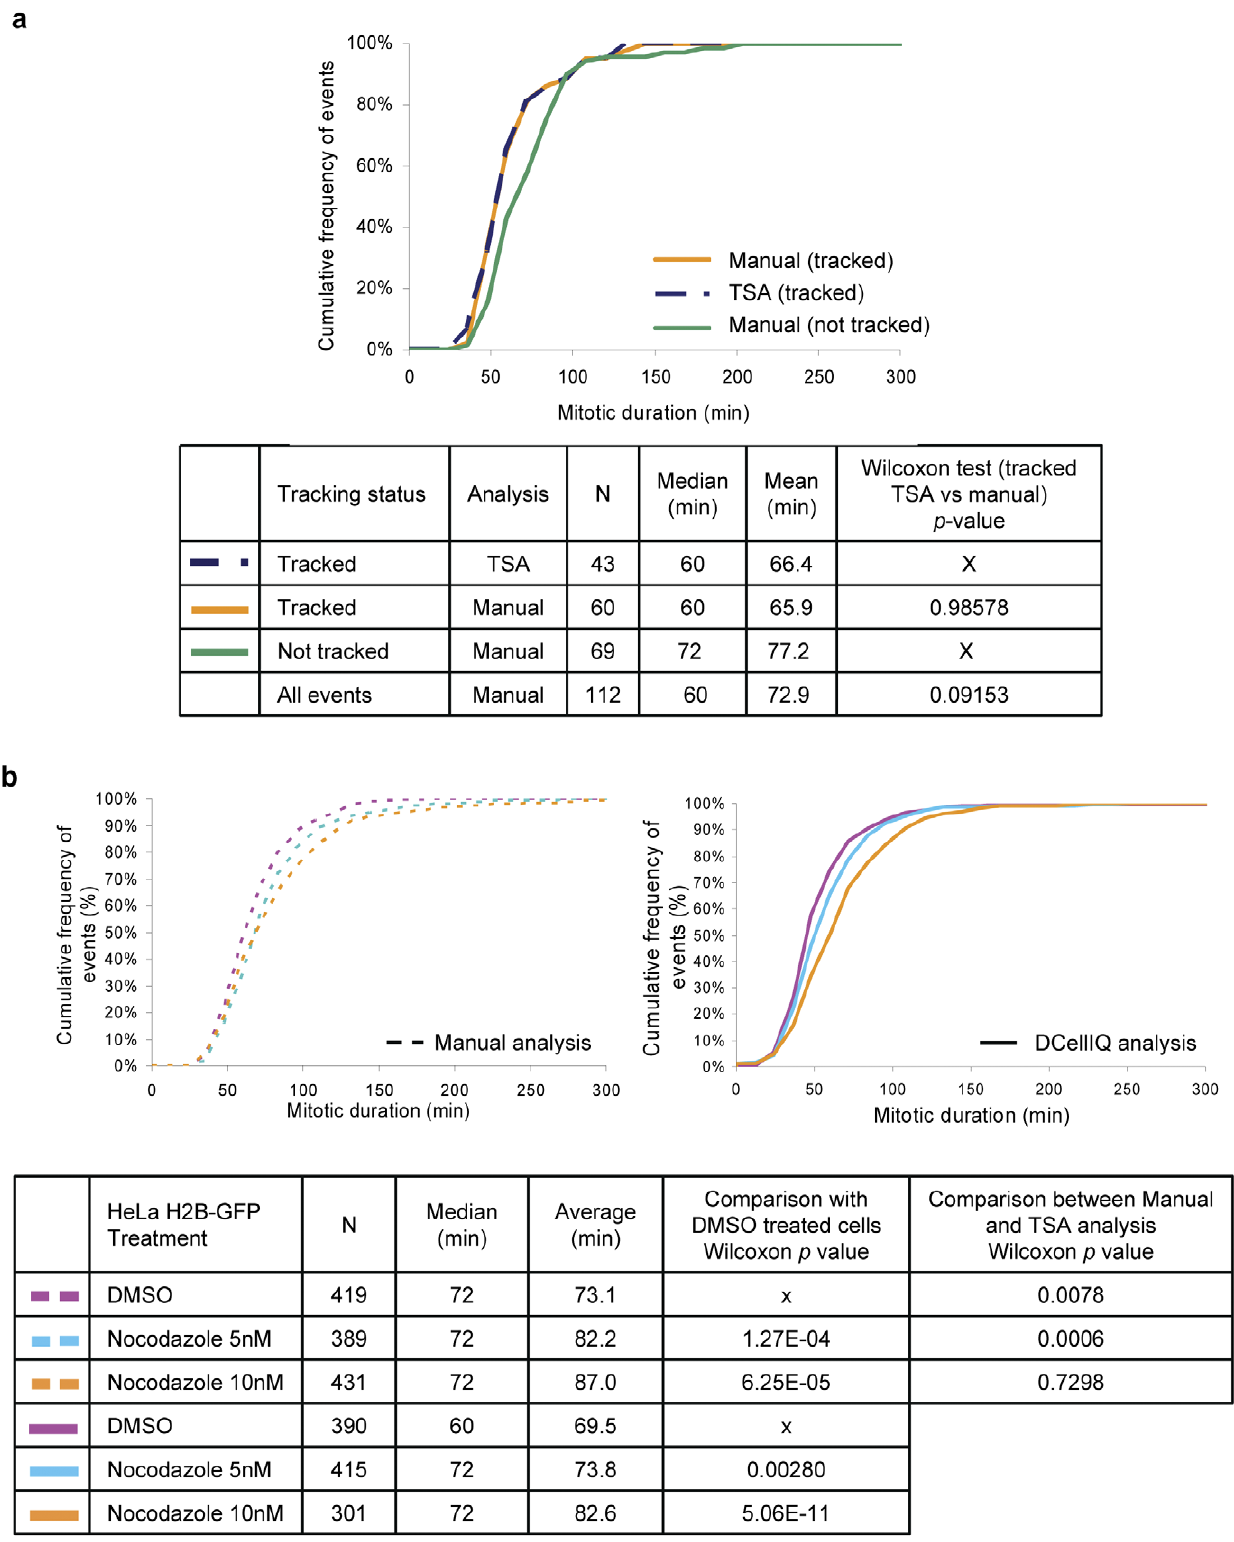
Figure 3. TSA detects small increases in mitotic duration when the spindle assembly checkpoint is activated by nocodazole. (a) HeLa H2B-GFP cells were imaged every 12 min for 48 hours after treatment with DMSO. Mitotic events from one movie, for nuclei that were successfully tracked, were measured by TSA (tracked successfully) and duration of these events was manually determined and both measurements were compared. Mitotic duration was also manually determined for cells that were not tracked successfully. Such cells were either not present in the imaging frame at all time throughout the movie or their trace showed potential errors of segmentation or tracking and were as a result excluded by